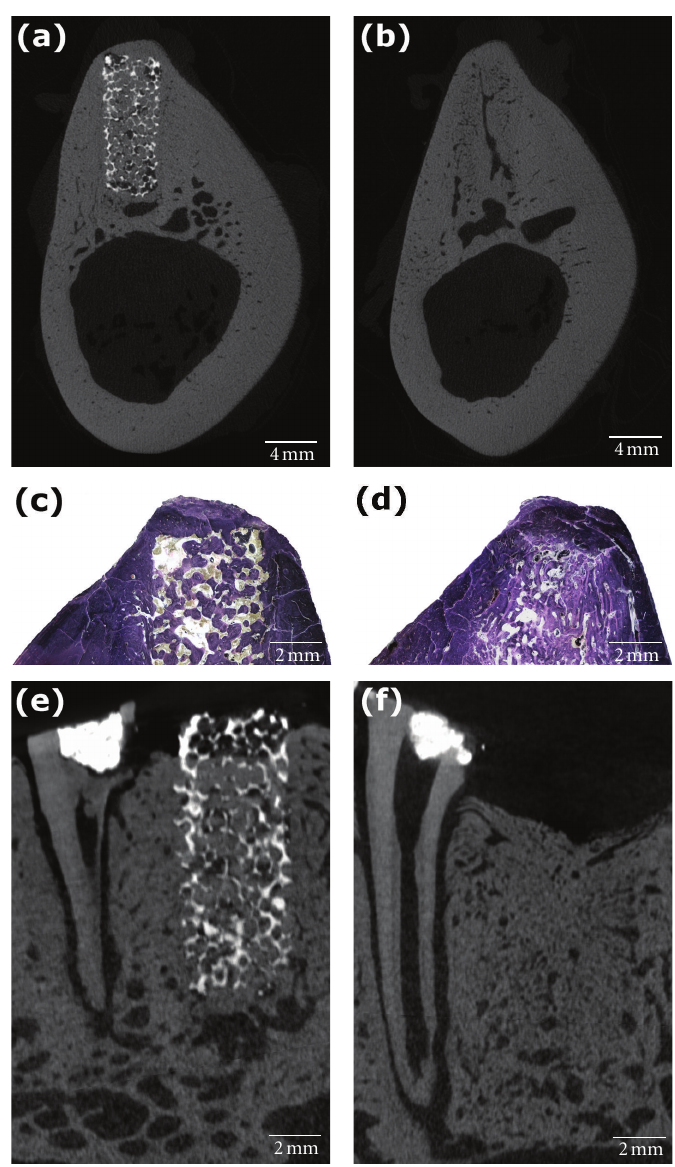
Figure 4: The sca ff olds were well integrated in the alveolar bone, and the TiO 2 sca ff old was not found to interfere with the normal healing sequence of the extraction socket (a–d). In few isolated instances (2/11), small portion of the sca ff old was exposed above the newly formed bone (e), while the loss of ridge height at a sham site is shown in (f).